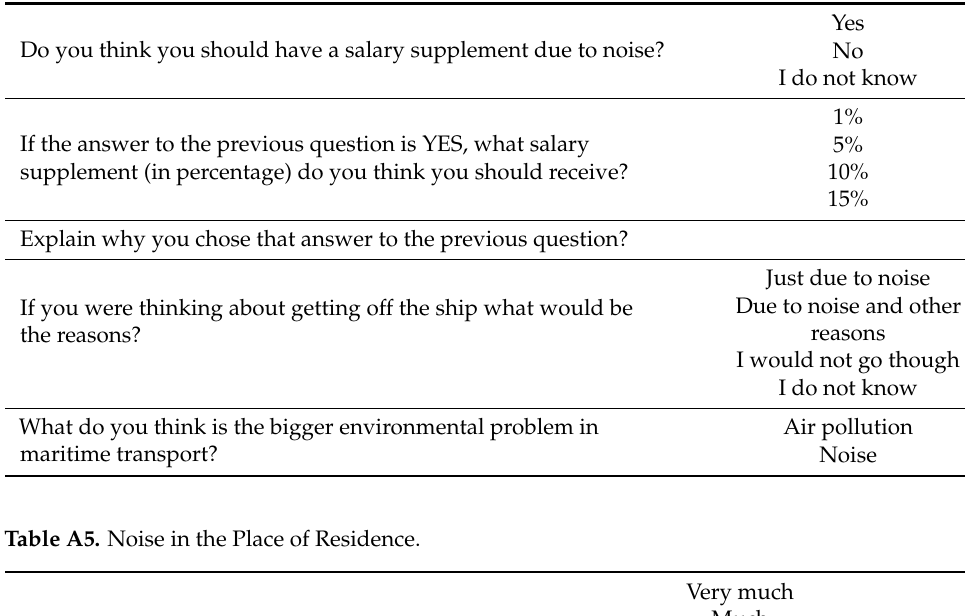
Table A5. Noise in the Place of